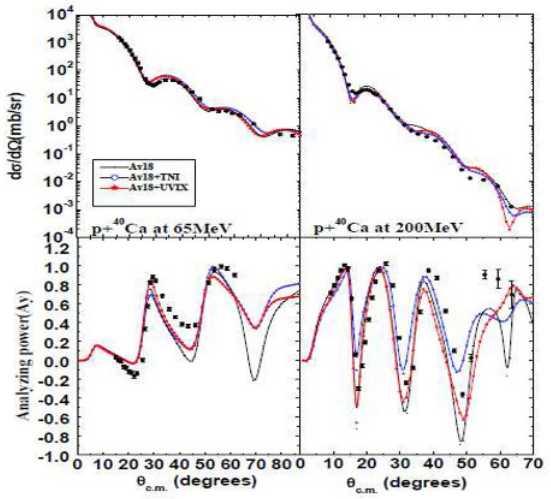
Figure 2: The differential cross section and the analyzing power for p - 40 Ca scattering.